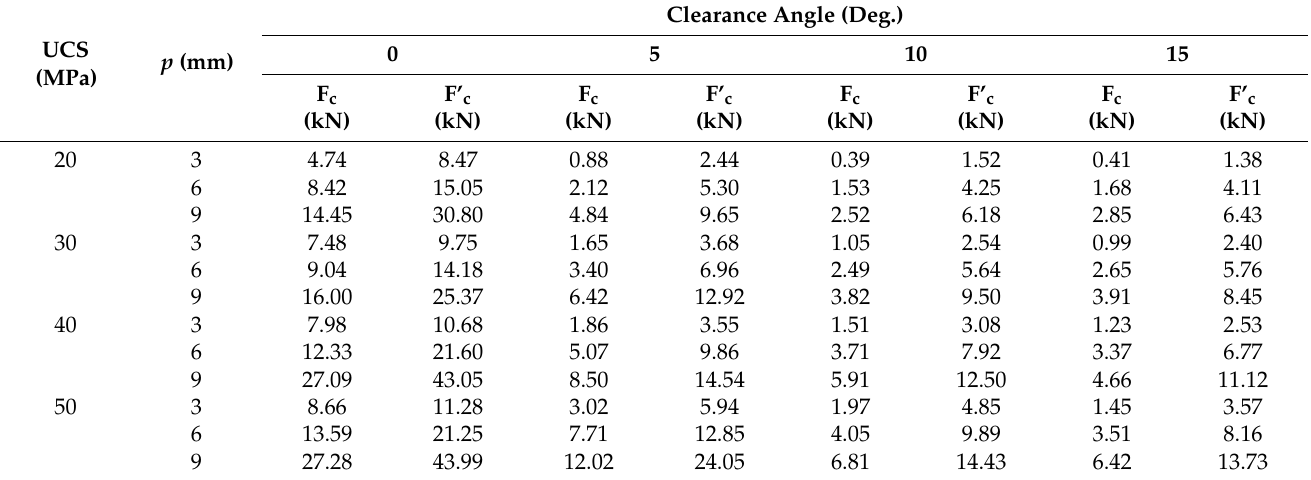
Table 3. Mean and peak cutting forces for various clearance